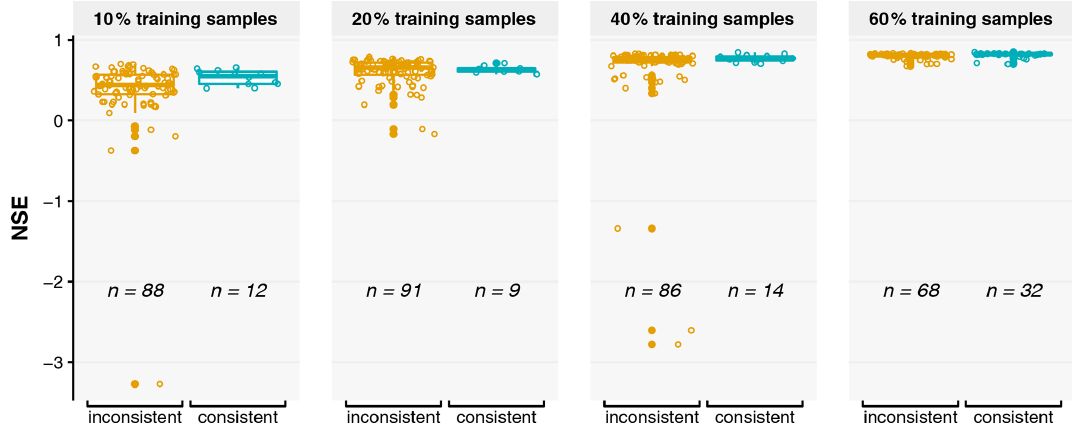
Figure 9. Box plot of the prediction accuracy, as measured by the Nash–Sutcliffe coefficient of efficiency (NSE), of the Washington Street SuDS site (WS) XGBoost models when samples of different sizes are used in model training. For each sample size, the models that offer consistent or inconsistent explanations are grouped together, and the numbers of consistent and inconsistent models (the n values) are shown. Observational SHAP values were used in the